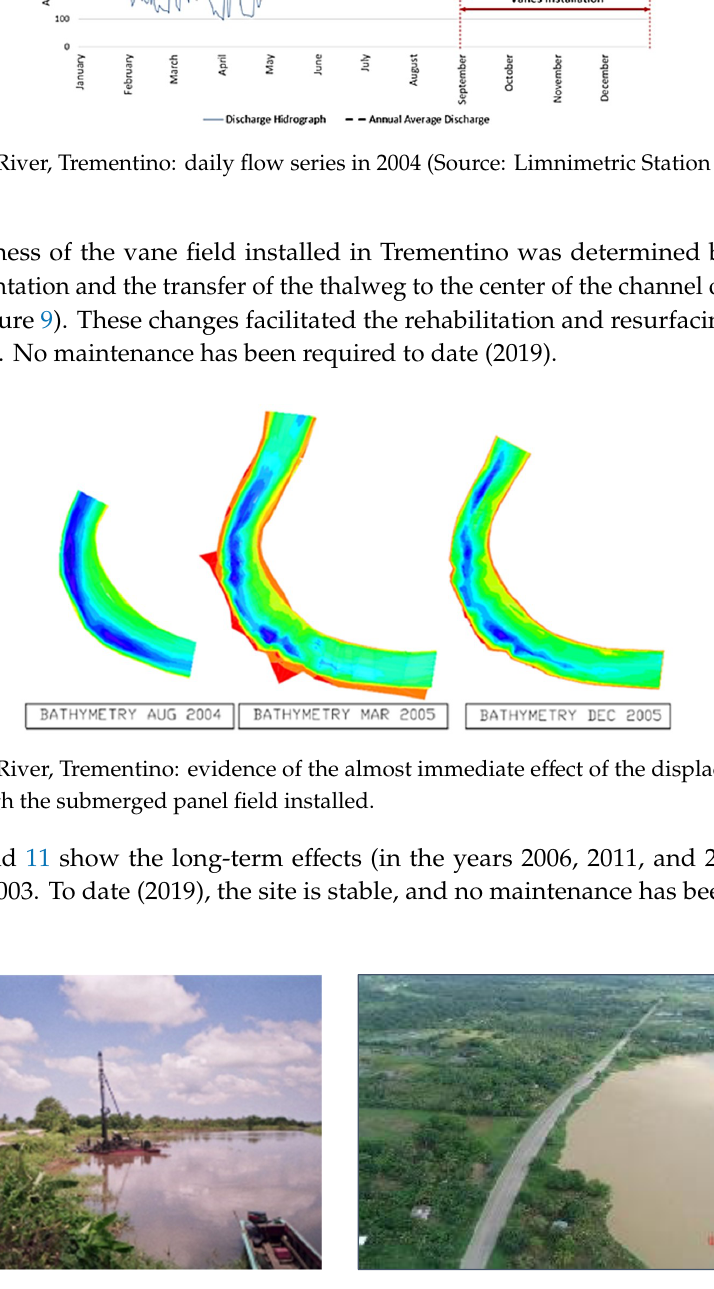
Figure 7. Sinú River, Trementino: ( a ) installation scheme; ( b ) characteristics of the panels (Hidroconsulta, 2004 [9]).